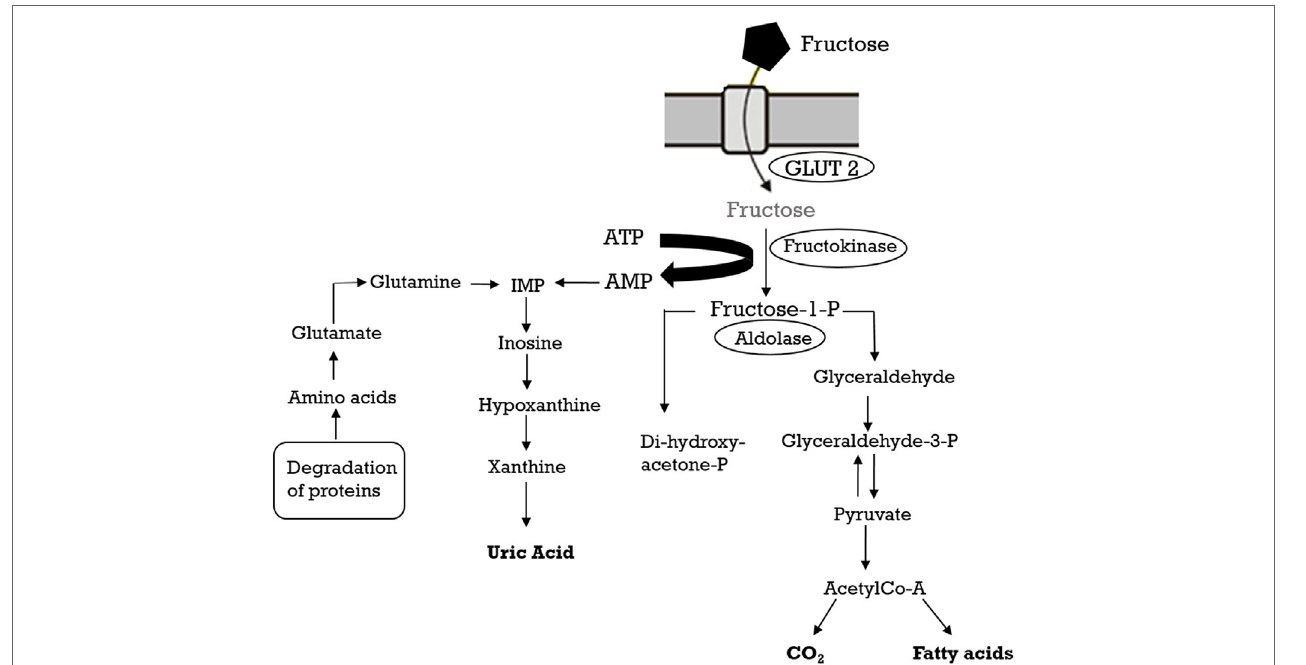
FigURe 2 | Fructose